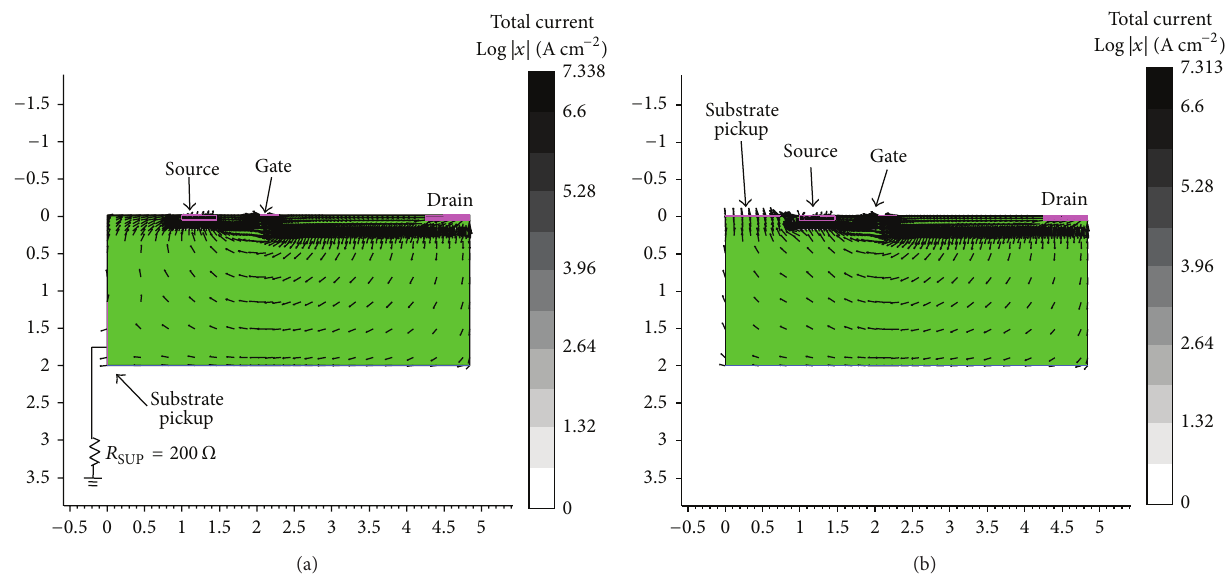
Figure 7: (a) The simulated 2D current distribution of the normal GGNMOS structure. Its substrate current is 4.22 mA with peak lattice temperature 880 ∘ K. (b) The simulated 2D current distribution of the butting structure. The substrate current of the butting structure is 325.9 mA with peak lattice temperature 1167 ∘ K. Similar simulated inserted structure has substrate current 298.1 mA with peak lattice temperature 1104 ∘